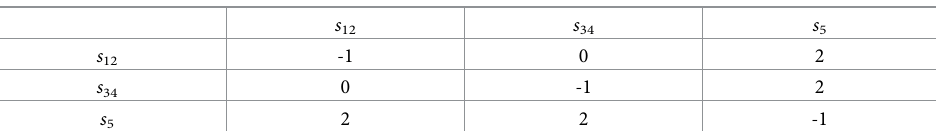
Table 9. Updated matrix A for the posets in Fig 15.